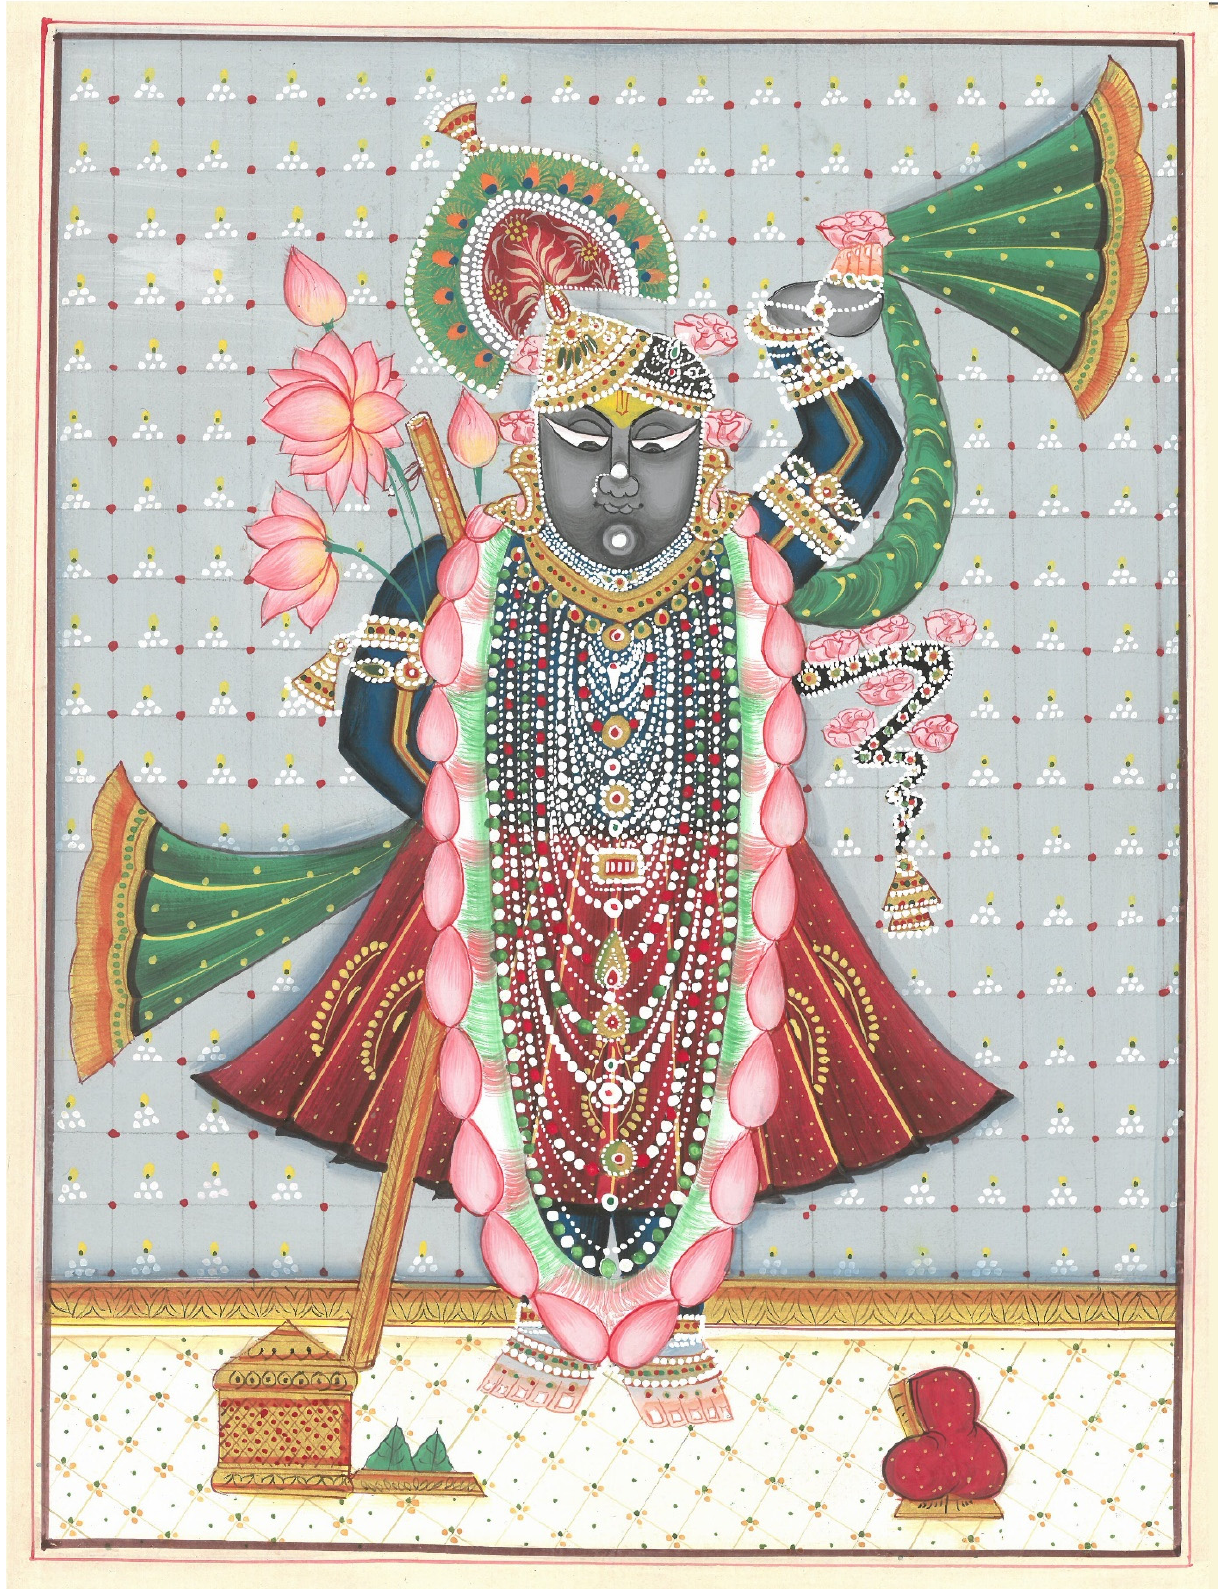
Figure 1. Ś r ī N ā th, modern painting from Nathdwara (private collection). Figure 1. ´Sr¯ı N¯ath, modern painting from Nathdwara (private